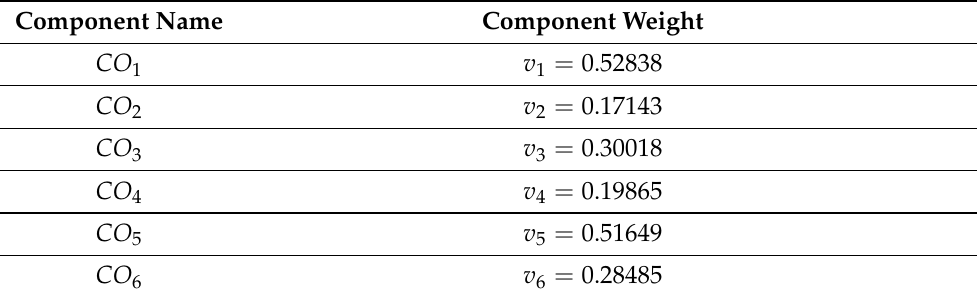
Table 17. Total weights of